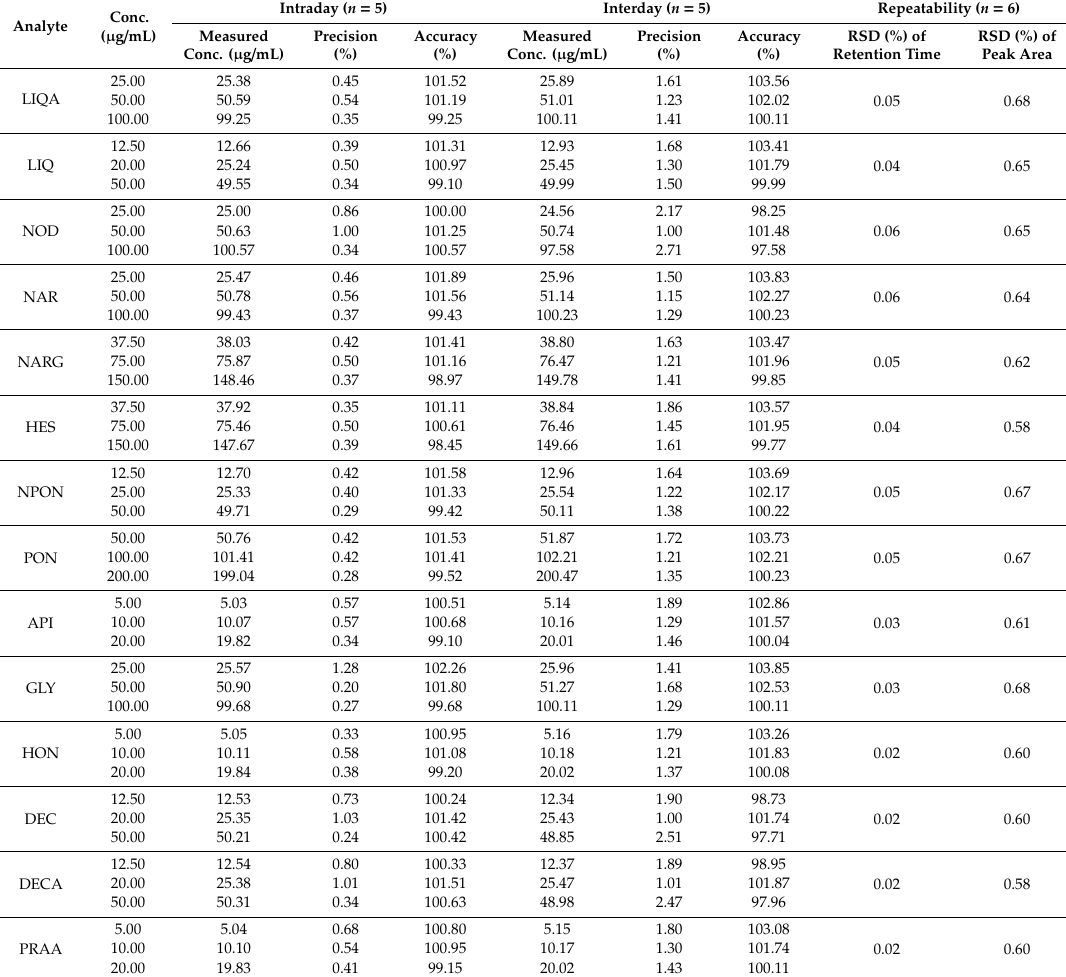
Table 3. Precision assay for the 14 marker compounds in SDGT using